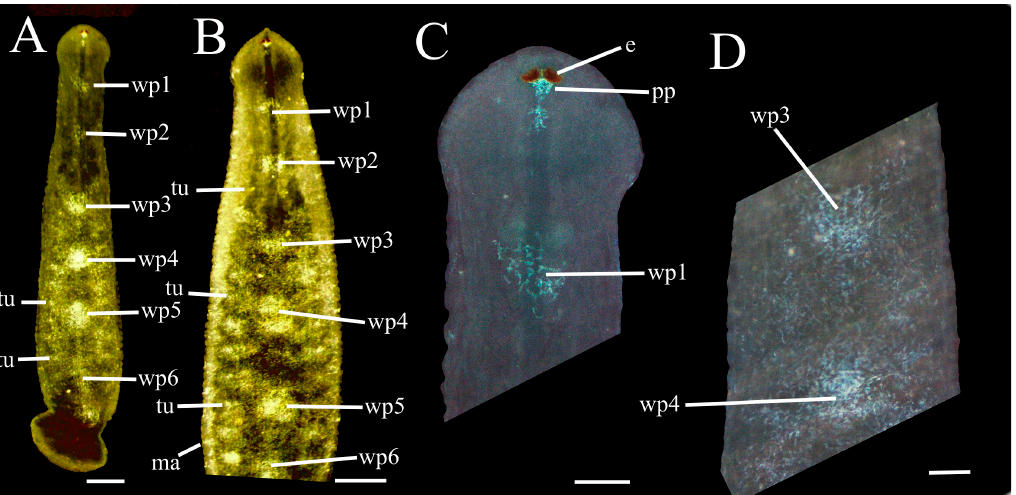
Figure 11. Cellular basis of white pigment patches manifest in hatchling P. parasitica but not in the adult. Shown are photomicrographs of hatchlings (PP ‐ 4b, 6.0 mm) of varying magnifications in transmitted LED light ( A , B ) and transmitted UV light ( C , D ). These aggregations of precursor cells are remarkably similar to those in early hatchlings of P. multilineata [9] (fig. 8). This suggests a close but developmentally divergent affinity between these two syntopic turtle leech species. Abbrevia ‐